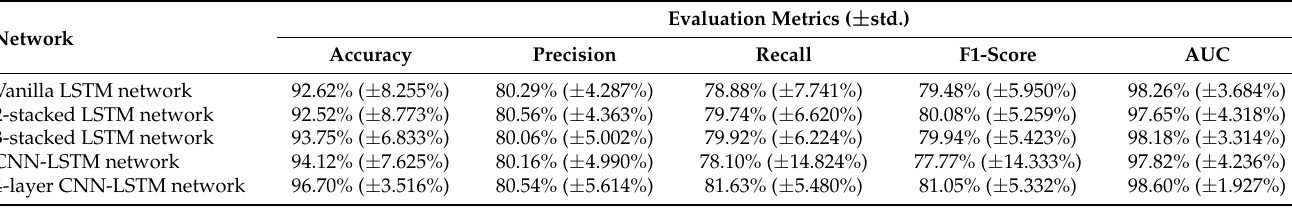
Table 10. Performance metrics of five LSTM networks used in the experiment by OW sample generation and LOSO cross validation protocol.